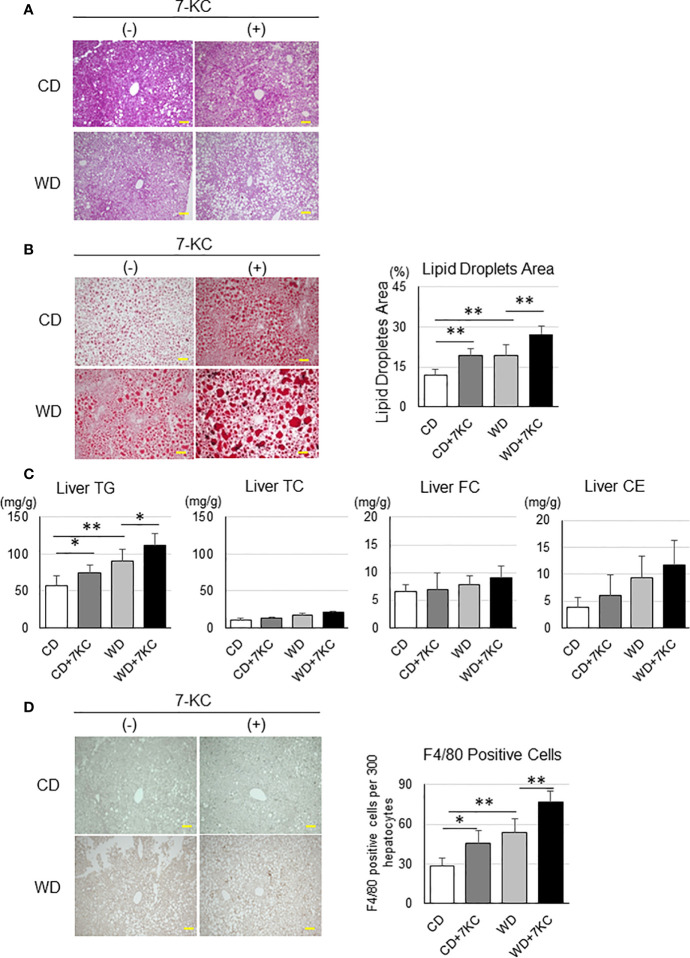
Addition of 7KC accelerated hepatic steatosis and inflammation in ob/ob mice fed CD or WD for 4 weeks. (A) HE staining in liver, (B) Oil Red O staining analysis, (C) hepatic lipid content, (D) F4/80 staining analysis. All values are presented as the means ± SD. ANOVA with Tukey test, n = 6 per group; Scale bars in (A, B, D) = 100 μm. *p < 0.05, **p < 0.01.